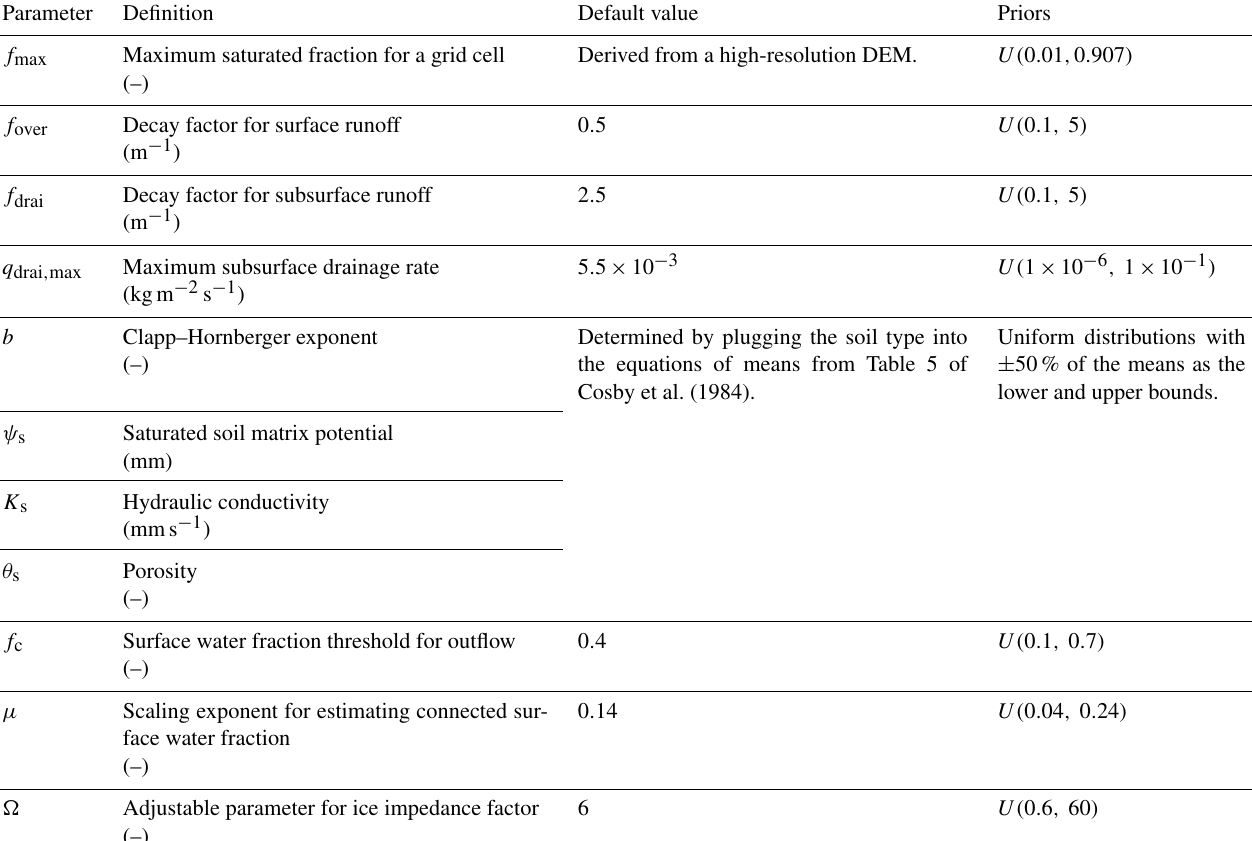
Table 1. Uncertain parameters’ information. Note: DEM is for digital elevation